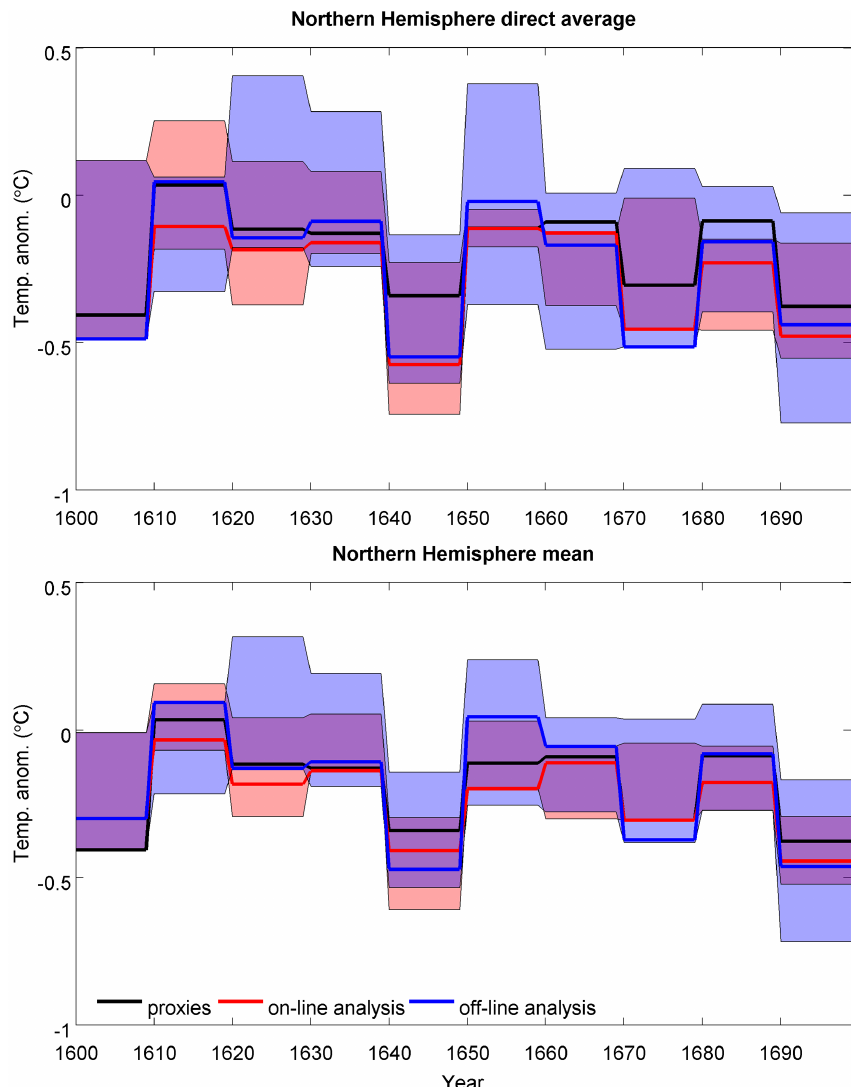
Figure 3. Direct average of the four Northern Hemisphere continental temperatures (anomalies w.r.t. the AD850–1850 mean) and NH mean for the 17th century, for the on-line (red shading) and off-line (blue shading) ensemble members, the on-line (red line) and off-line DA analysis (blue line), and the proxy-based reconstructions (black